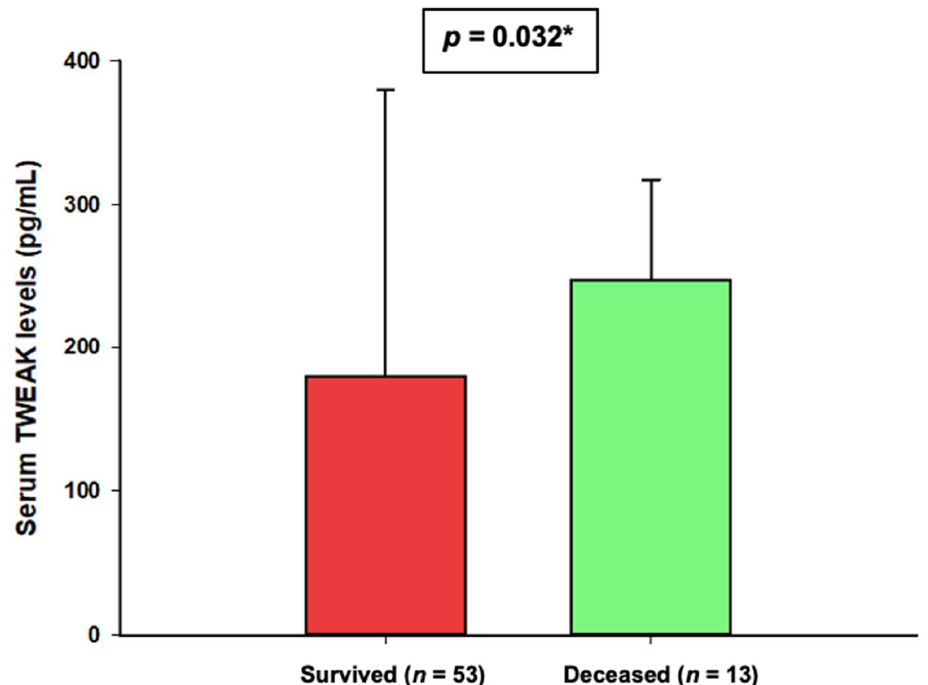
Figure 1. Comparison of serum TWEAK with regards to in-hospital mortality. Data are presented as median and 75th percentile * Mann–Whitney U test.